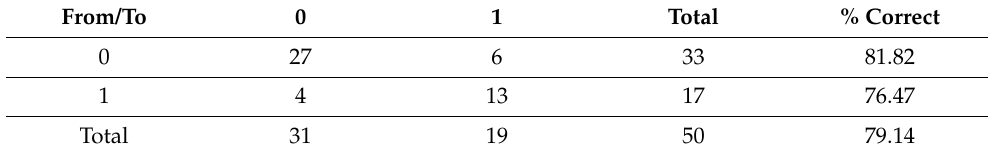
Table 8. Confusion matrix of